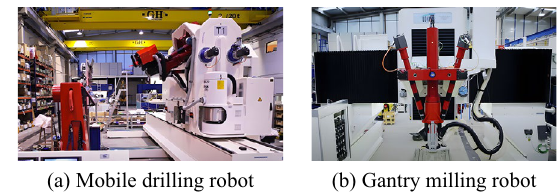
Figure 15 Mobile machining center based on parallel robot [53]